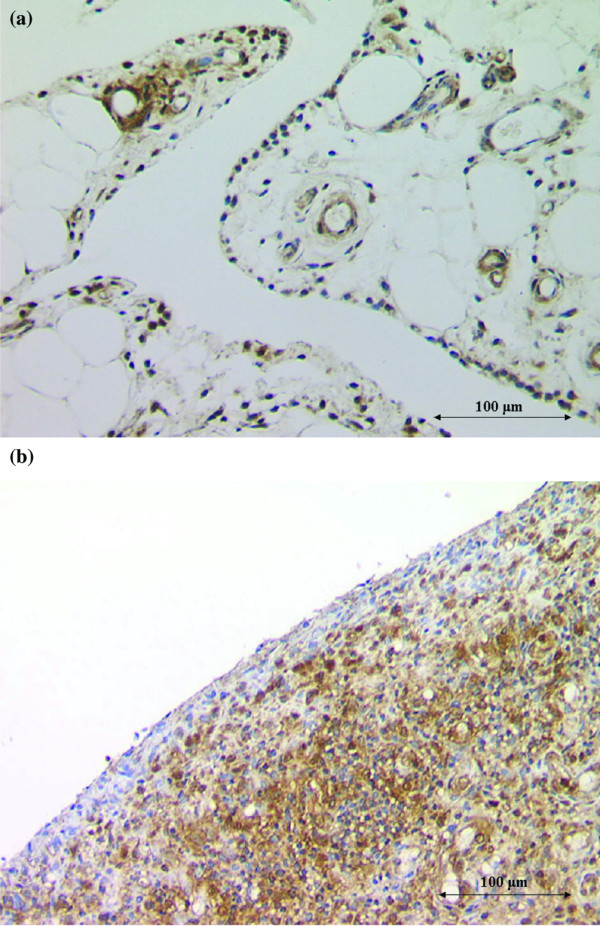
Localisation of α-enolase in synovial membranes. Immunohistochemistry of biopsy sections from patients with osteoarthritis (a) and rheumatoid arthritis (RA) (b) with the goat anti-α-enolase antibody showing expression of α-enolase (stained brown) in cells in the subsynovium of the patient with RA and in endothelial cells in the patient with osteoarthritis. Cell nuclei are counterstained blue.